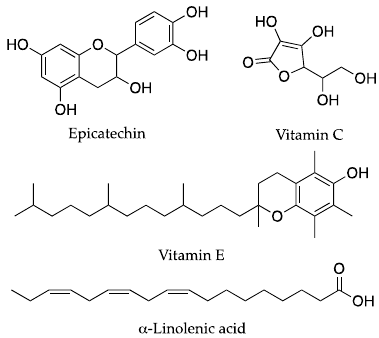
Figure 6. Chemical structures of dietary compounds that act as antioxidants through mixed mechanisms to exert their anti-aging or rejuvenation effects.